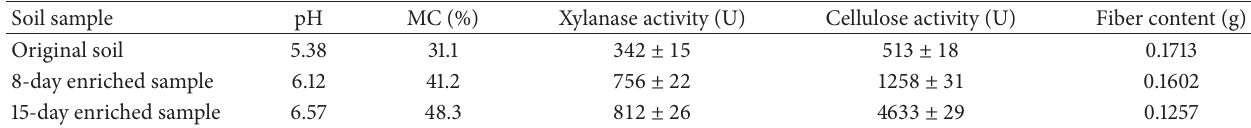
Table 1: Sample properties and their lignocellulose-degrading capabilities.